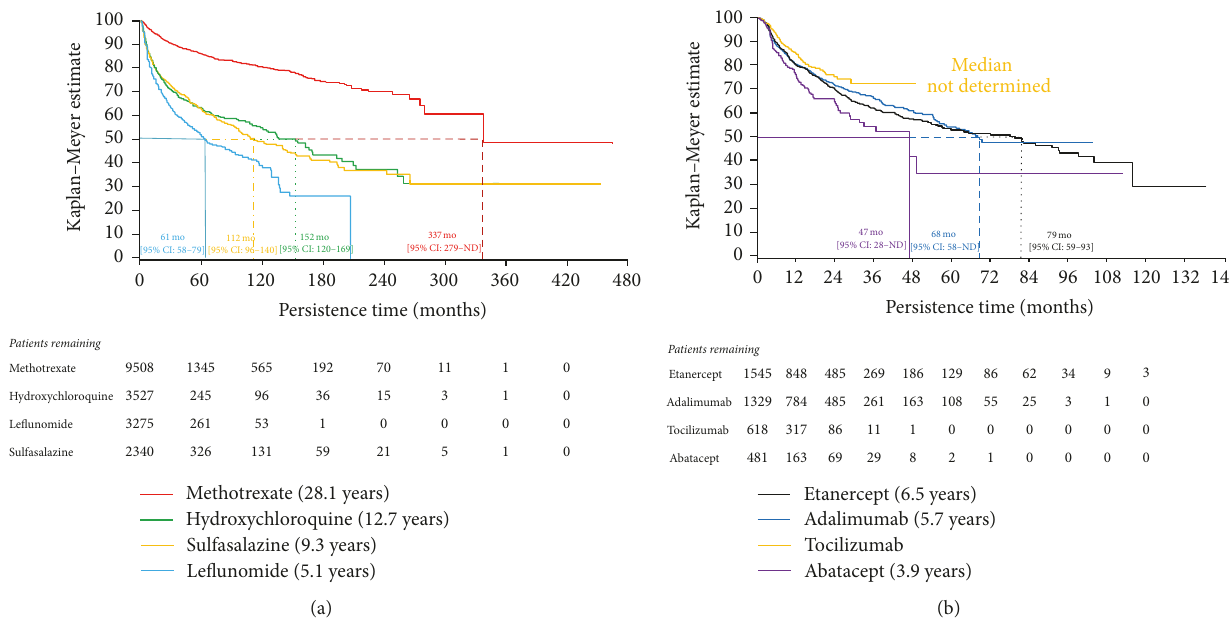
Figure 1: Kaplan-Meier plot of treatment survival: (a) cDMARDs and (b) bDMARDs. ND = not determined.